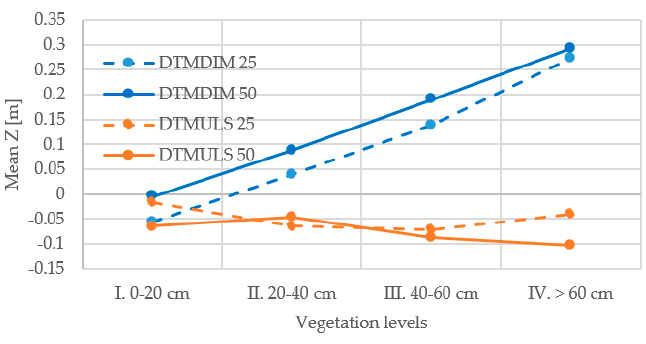
Figure 10. Comparison of DTM DIM and DTM ULS , to DTM ALS .